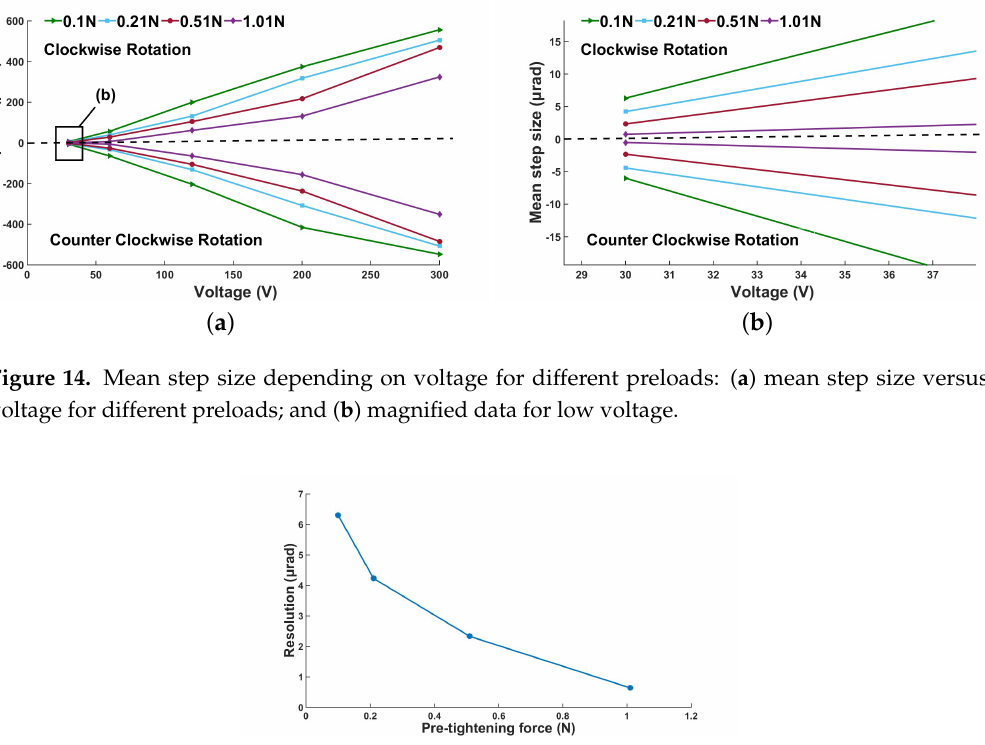
Figure 15. The relationship between resolution and pre-tightening